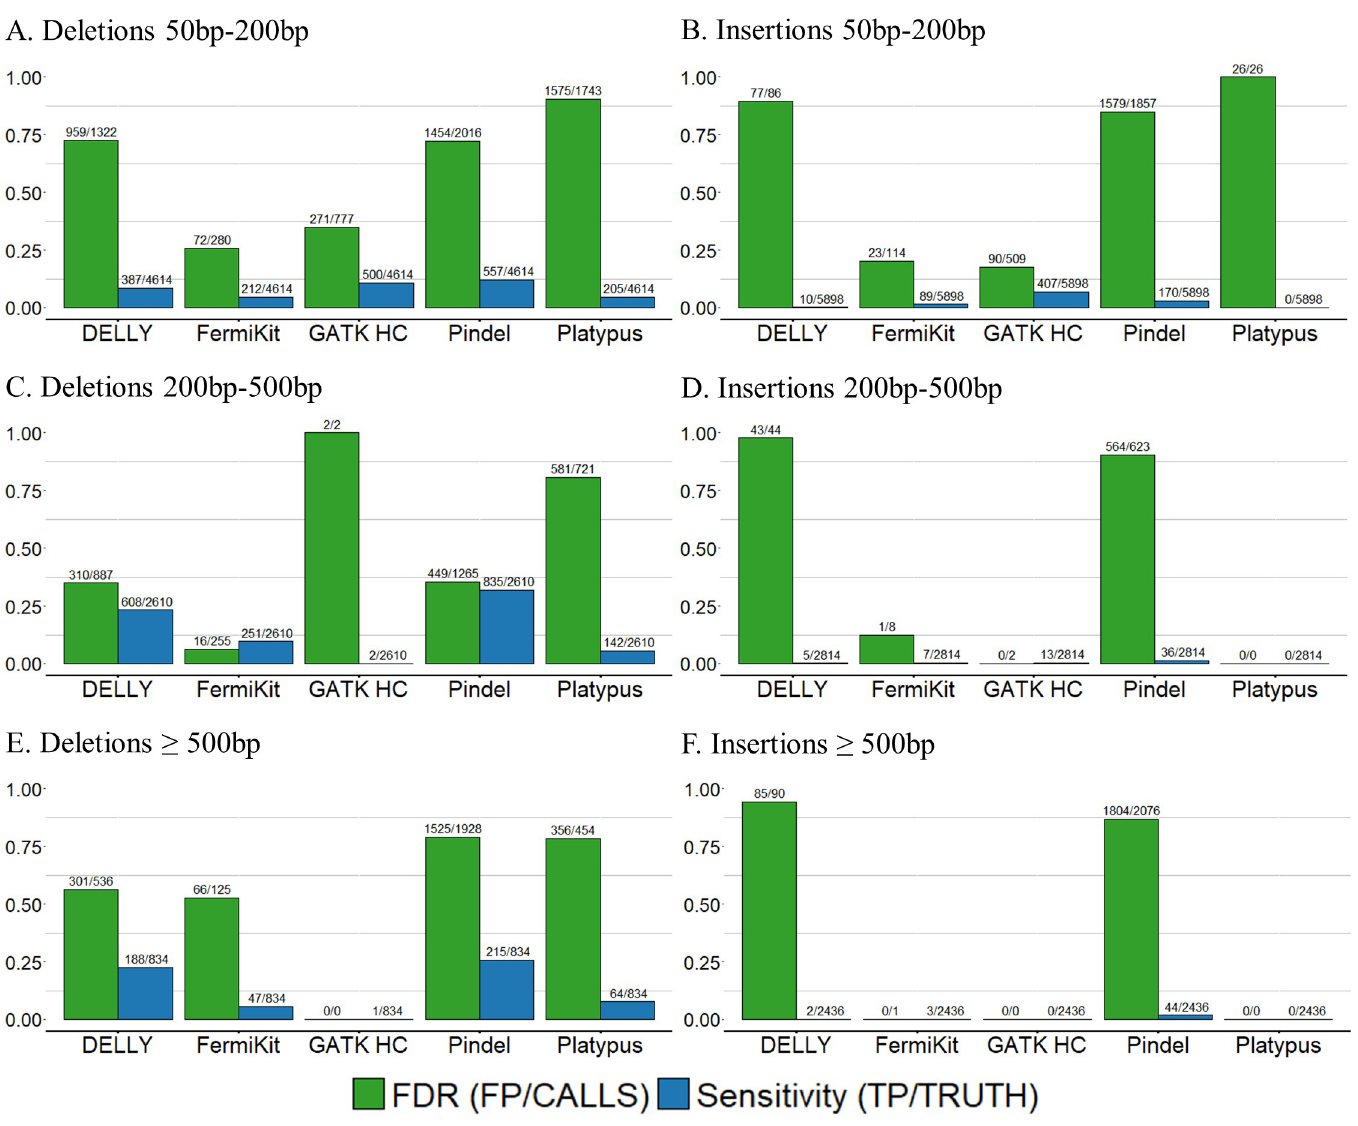
Fig 8. Indel calling results for variant calling tools with CHM1 cell line sequencing data. (A) The FDRs and sensitivities of deletion calls in size range 50bp – 200bp. (B) The FDRs and sensitivities of insertion calls in size range 50bp – 200bp. (C) The FDRs and sensitivities of deletion calls in size range 200bp – 500bp. (D) The FDRs and sensitivities of insertion calls in size range 200bp – 500bp. (E) The FDRs and sensitivities of deletion calls in size range � 500bp. (F) The FDRs and sensitivities of insertion calls in size range � 500bp. The number of FPs and the number tool-detected indels are listed above FDRs. The number of TPs and the number of indels in truth set are listed above